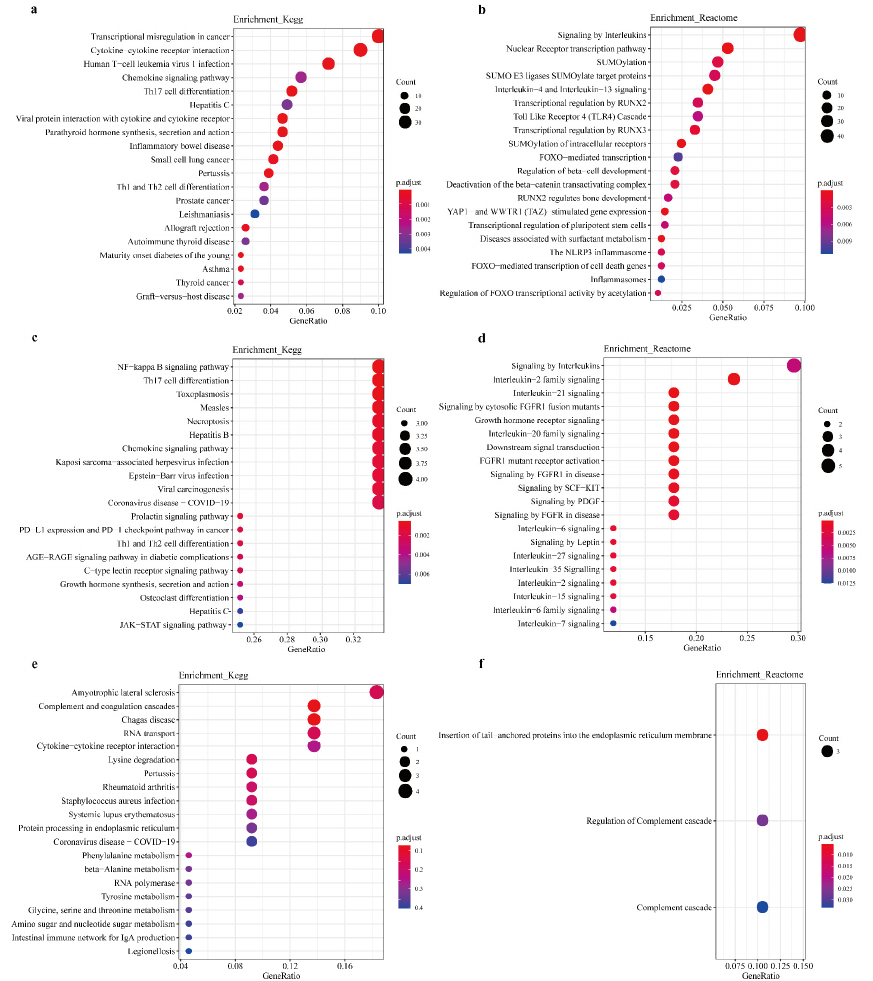
Figure 6. Functional annotations of the 3 COVID-19-related gene modules. ( a ) KEGG and ( b ) Reactome pathway enrichment analyses of the 903 genes in module 1. ( c ) KEGG and ( d ) Reactome pathway enrichment analyses of the 20 genes in module 2. ( e ) KEGG and ( f ) Reactome pathway enrichment analysis of the 46 genes in module 3.